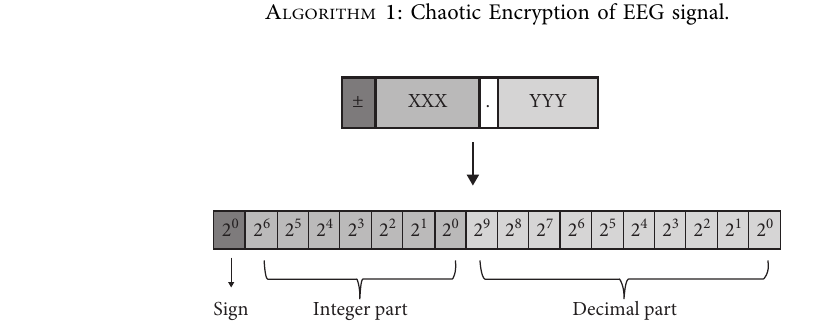
Figure 13: Binary representation of the modulated samples using 18